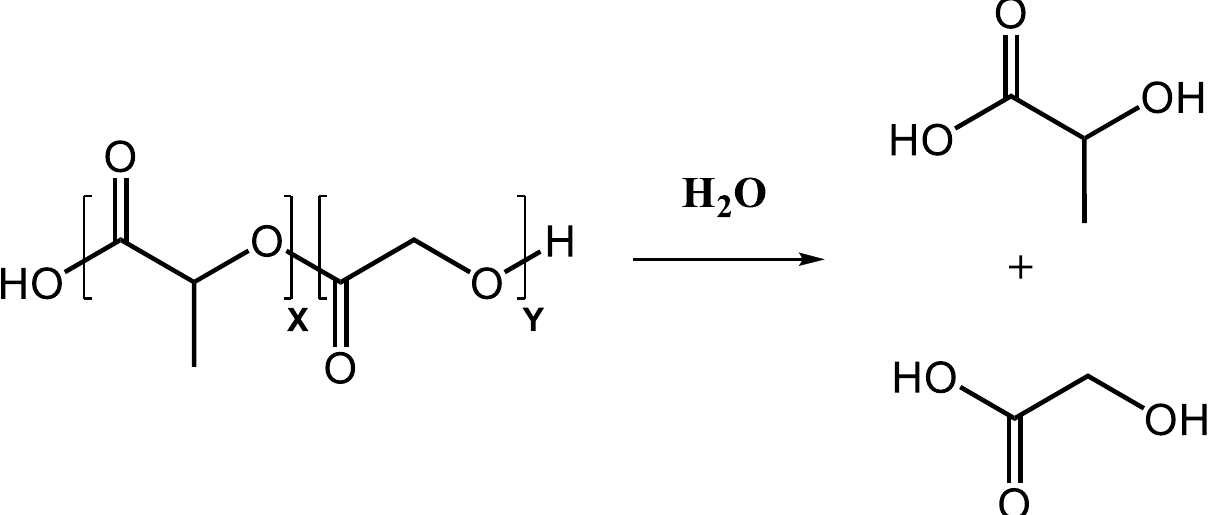
Figure 2. Chemical structure of PLGA and hydrolysis into the monomers lactic acid and glycolic